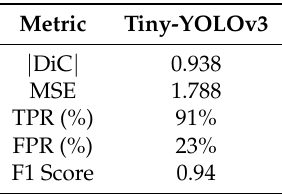
Table 3. Network evaluation metrics for testing source and target differences.